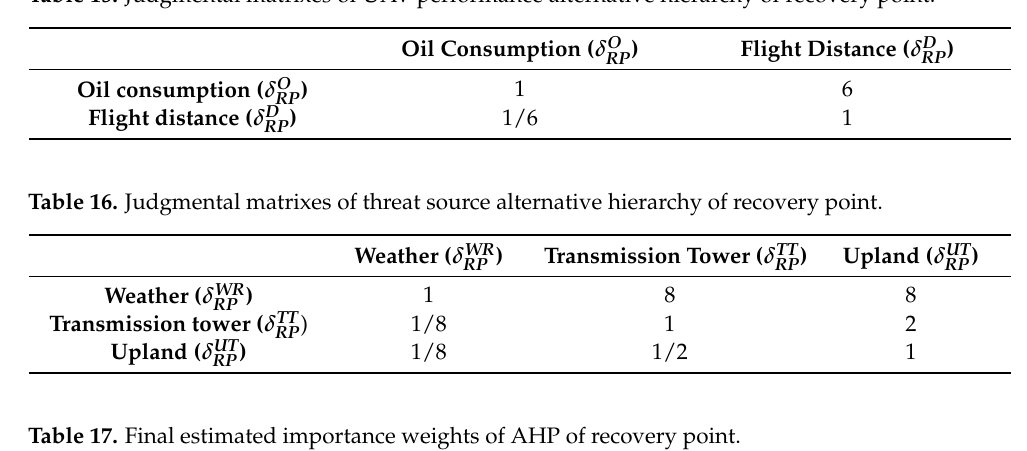
Table 15. Judgmental matrixes of UAV performance alternative hierarchy of recovery point.